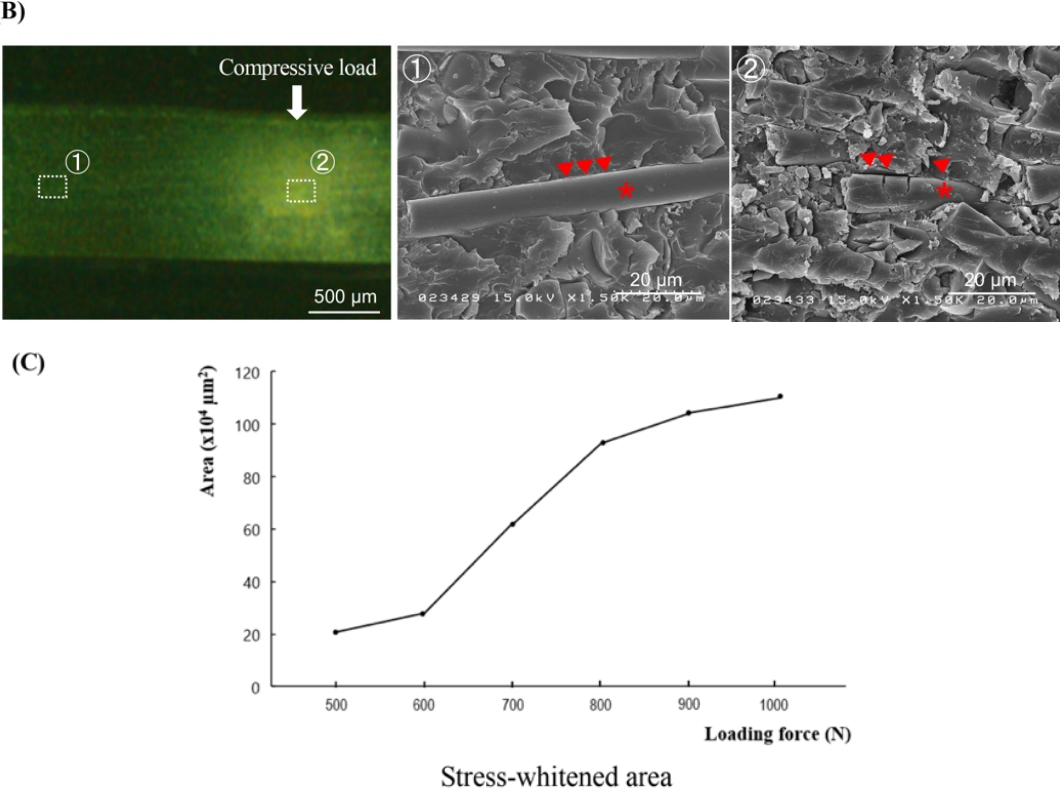
Figure 3. Results of the indentation test following the loading of forces from 500 to 1000 N. ( A ) Light microscopic images of the tested bone pieces in cross-sectional view. Bar = 1000 µm. ( B ) SEM images of the synthetic bone after the loading of force, compared between the intact ( ① ) and stress-whitened ( ② ) areas. Bar = 20 µm. The asterisk represents the glass fiber, and the arrowhead indicates the border between the resin matrix and the glass fiber. ( C ) A line graph shows the mean values of area under stress for each level of force applied.